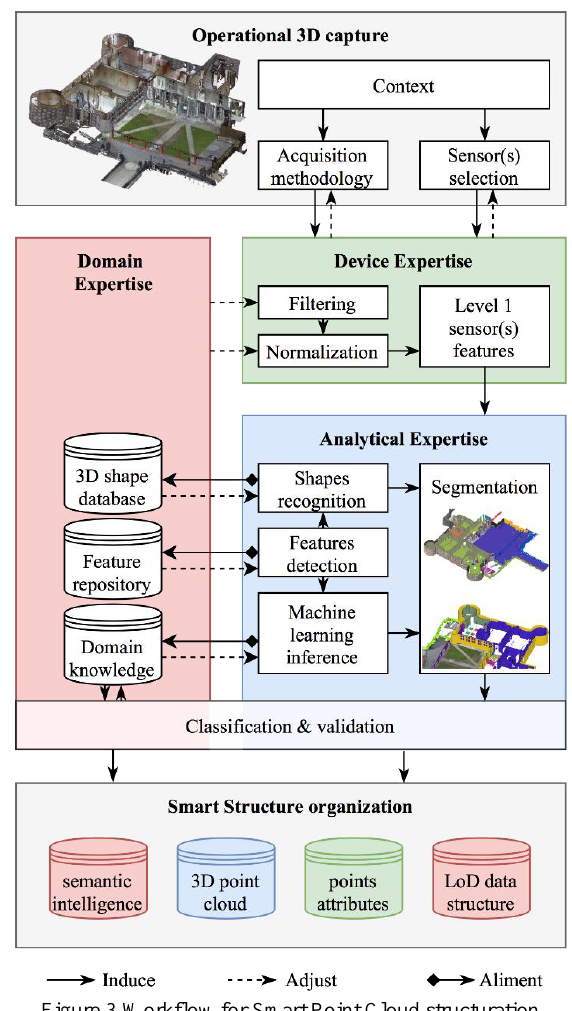
Figure 3 Workflow for Smart Point Cloud structuration We differentiate geometrical reasoning from statistical and machine learning, with a priori relationship estimation. While the validation takes place, we propose to detect and